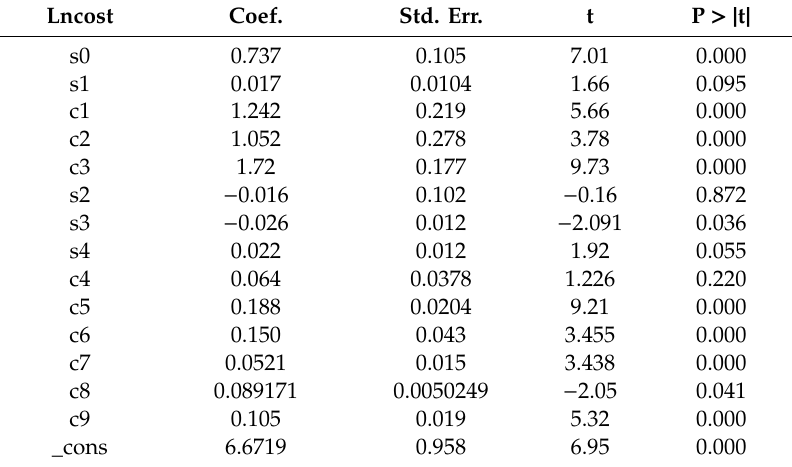
Figure 3. Adjusted Lerner Index for the Period 1996–2016. Table 6. Adjusted Lerner Cost Function Estimate Fixed Effect with 848 Observations. Dependent